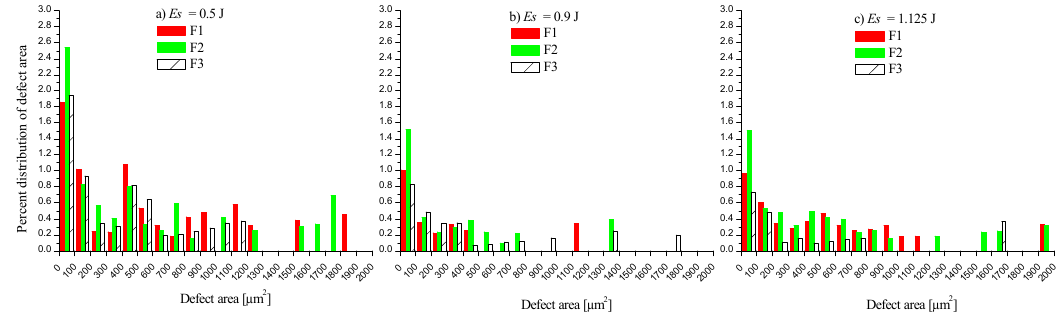
Figure 14. Analysis of the percent distribution of the defect area observed in the deposit at ( a ) 0.5 J (V1, C2), ( b ) 0.9 J (V2, C1) and ( c ) 1.125 J (V2, C2) for different values of frequency F1 < F2 < F3.